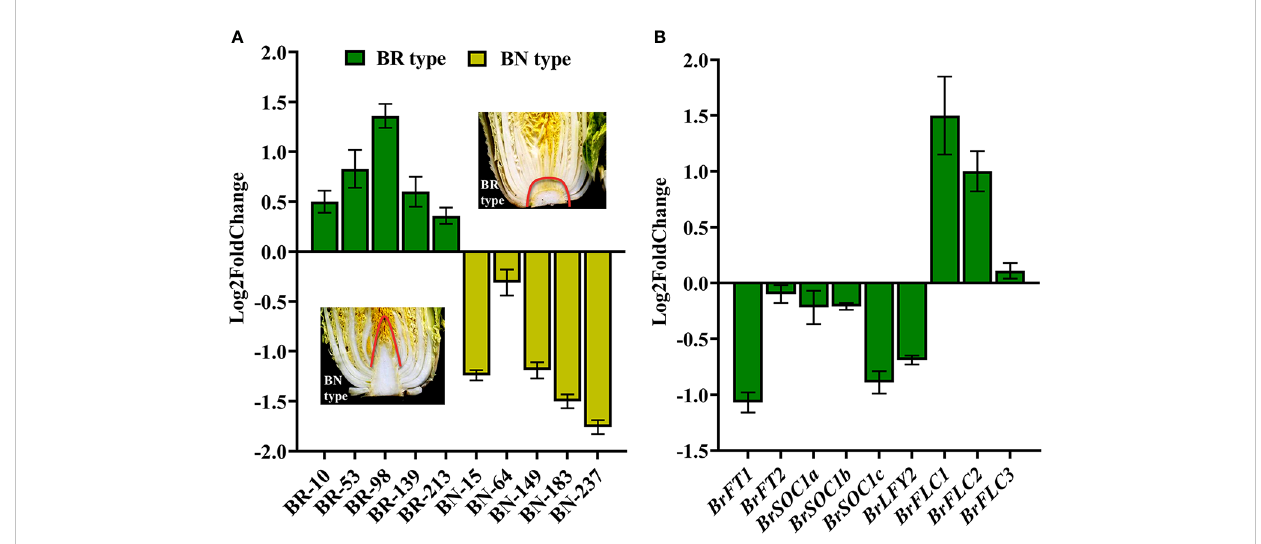
FIGURE 3 Expression patterns of BR1 (A) and representative mark genes (B) in bolting resistant or non-resistant Chinese cabbage during heading stage. Examples of bolting resistant type (BR type) and bolting non-resistant type (BN type) Chinese cabbage were showed in the fi gure. Green column represented BR type, yellow column indicated BN type. BR type inbred lines ‘ BR-98 ’ was used for expression